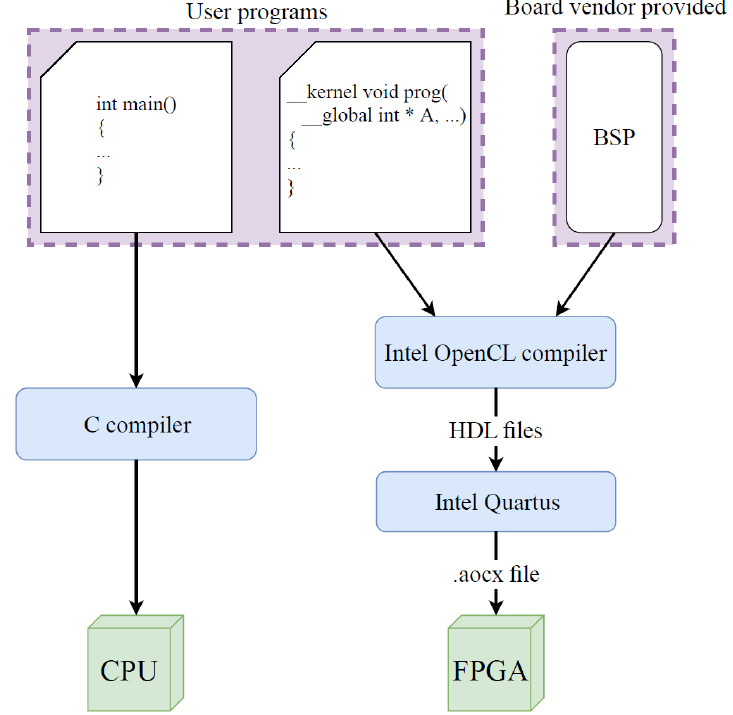
Figure 3. OpenCL and C programming steps to generate an FPGA configuration